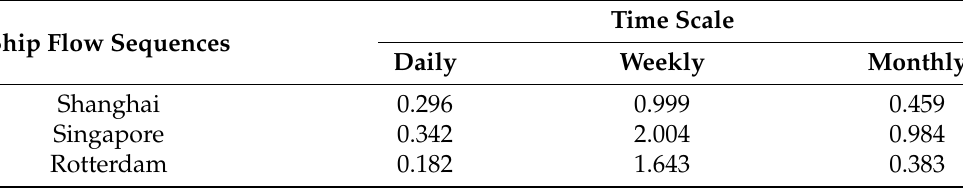
Table 4. The strength of multifractality for ship flow sequences.